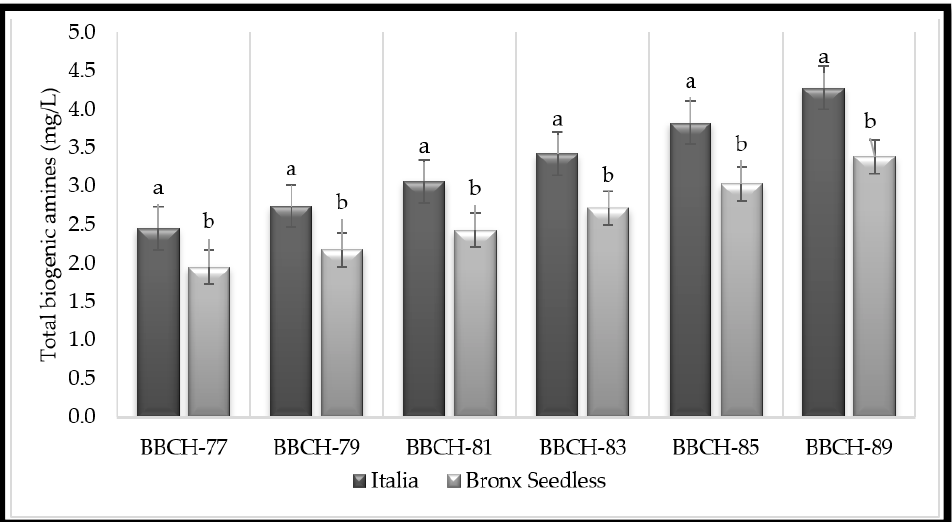
Figure 1. Total content of biogenic amines in Italia (black) and Bronx Seedless(grey) table grapes harvested in six different phenological stages (BBCH-77, BBCH-79, BBCH-81, BBCH-83, BBCH-85, and BBCH-89). Data are expressed as the mean of the data with their corresponding standard deviation. For a given variable and phenological stage, different letters over the bars represent significant differences (Duncan test, p < 0.05).